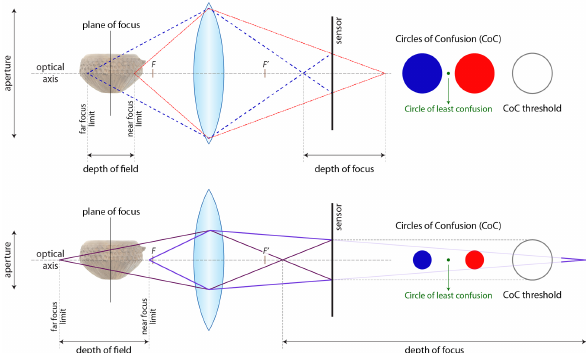
Figure 3. The influence of aperture size on the DoF, the depth of focus and the far and near focus limits.